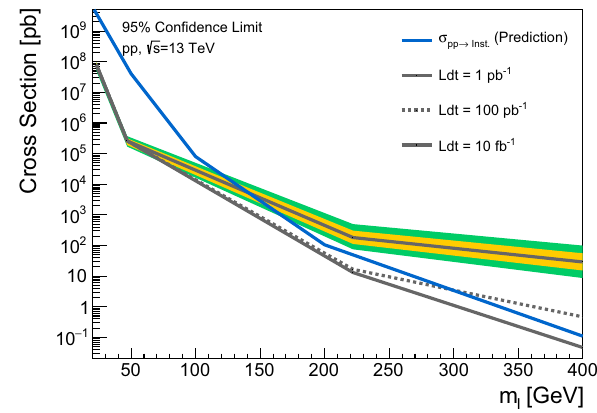
Fig. 19 Predicted distribution of the event thrust of the Monash soft- QCD tune of Pythia8 as well as a modified version with significantly enhanced multiple parton interaction probability ( MPI:alphaSvalue = 0.150 ) in comparison to the measurement at 13 TeV of the ATLAS